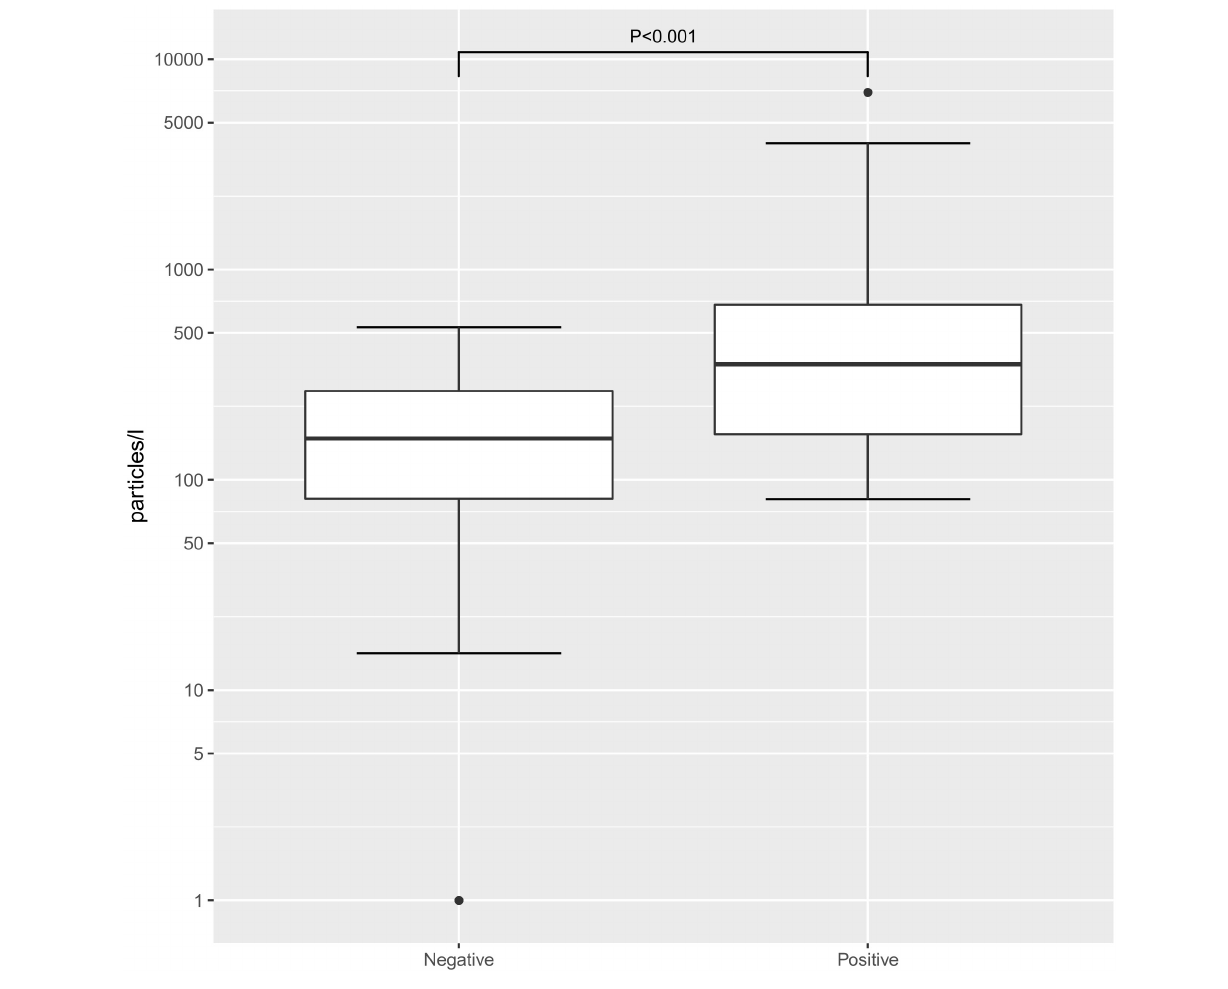
FIGURE 1 | Exhaled particle counts in severe acute respiratory syndrome coronavirus 2 (SARS-CoV-2) polymerase chain reaction (PCR)-positive and -negative children. Exhaled particle counts in particles/L Exhaled particle counts in particles/L, displayed on a logarithmic